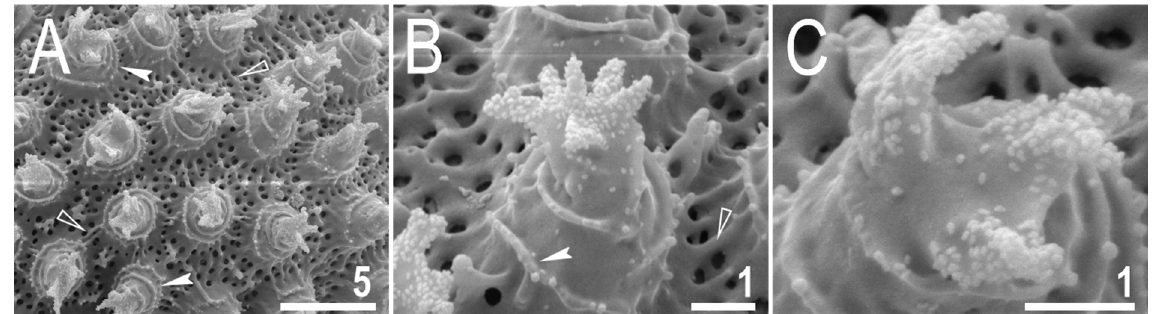
Figure 11. Mesobiotus marmoreus sp. nov. —SEM images of eggs: ( A )—details of the egg surface; ( B )—egg process; ( C )— top part of the processes divided into several tentacular arms covered with fine granulation. Empty flat arrowheads indicate elevated bars of the reticulum that are visible as extending striae radiating from processes bases in PCM (see Figure 9), filled indented arrowheads indicate annulations present on the process trunks. Scale bars in μ m. Table 6. Measurements [in μ m] of the eggs of Mesobiotus marmoreus sp. nov. ; eggs mounted in Hoyer’s medium; process base/height ratio is expressed as percentage; N—number of eggs/structures measured, RANGE refers to the smallest and the largest structure among all measured specimens; SD—standard deviation.